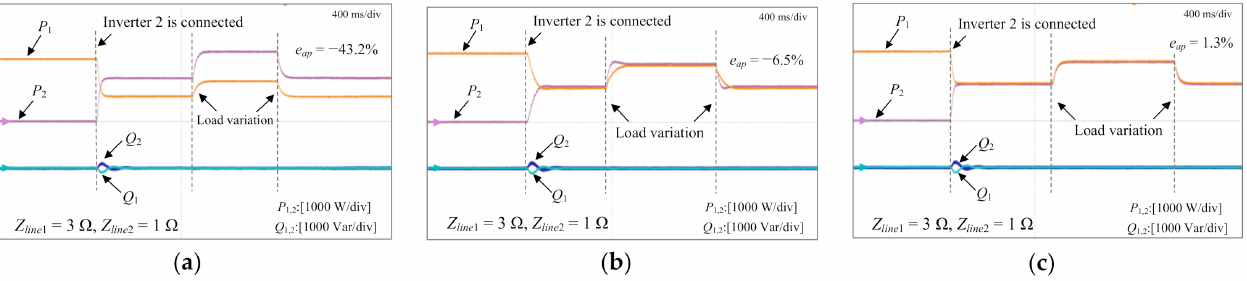
Figure 16. Experimental results of power responses with line impedance ratio of 3:1: ( a ) power sharing performance via conventional P-U/Q-f droop control method; ( b ) power sharing performance via PI-based P-U/Q-f droop control